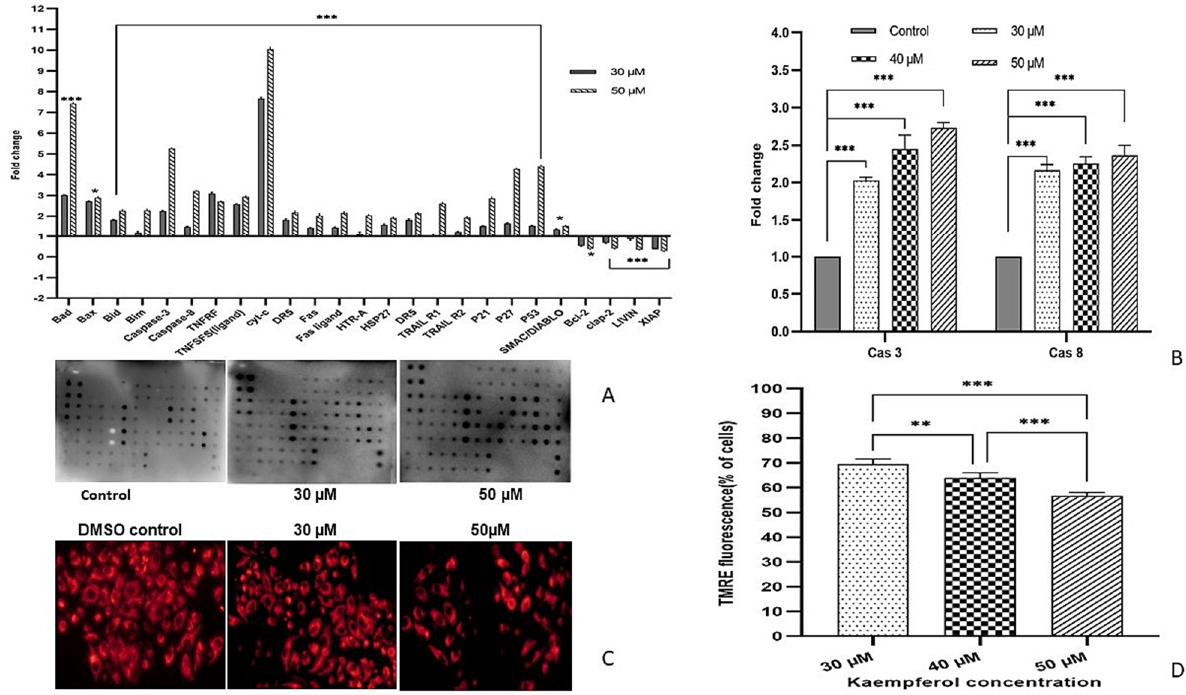
Figure 4. ( A ) Graph represents modulated protein expression as fold change compared to control. Kaempferol treatment upregulated pro-apoptotic protein, whereas anti-apoptotic proteins were found to be downregulated. Images of nitrocellulose membrane showing differential protein expression of various apoptotic proteins in control and the kaempferol-treated sample (30 and 50 µM of kaempferol for 48 h). ( B ) Evaluation of caspase 3 and caspase 8 activity in kaempferol-treated HeLa cells at 30, 40 and 50 µM for 48 h. Graph represents increase in fold change of caspase 3, and 8 activity compared to control. ( C ) Fluorescent microscopic images showing TMRE fluorescence intensity reduction in a dose-dependent manner of kaempferol-treated HeLa cells (30, 40, and 50 µM for 48), signifying reduction in mitochondrial membrane potential. (D) Graphical representation of TMRE fluorescence expressed as % of kaempferol-treated HeLa cells (30, 40 and 50 µM for 48 h) in comparison to control. Data are presented as the mean ± standard deviation of three independent experiments. Two way–ANOVA*= p < 0.05; ** = p < 0.01, *** p < 0.001.